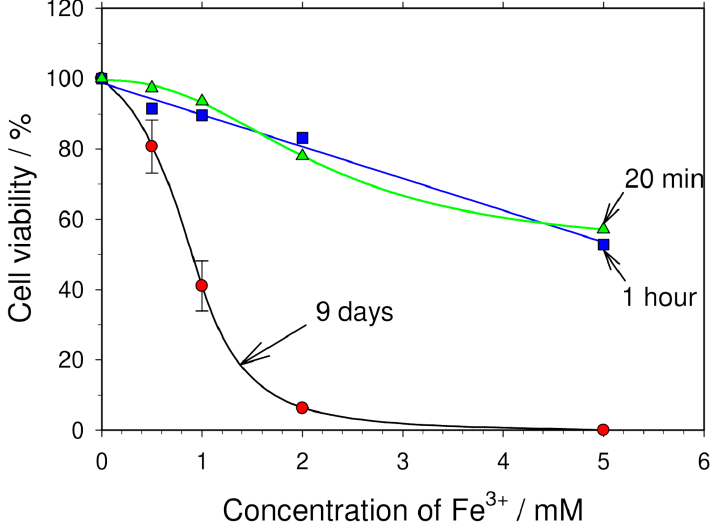
Figure 7. Influence of iron ions on the cell viability depending on the time of incubation. The influence of the Fe 3+ ions on the viability of mouse hepatoma MH-22A cells (ordinate) for various durations of the incubation of cells in the medium supplemented with Fe 3+ . The abscissa axis shows what concentration of Fe 3+ ions was added into the medium. The cell viability was estimated by a colony-forming